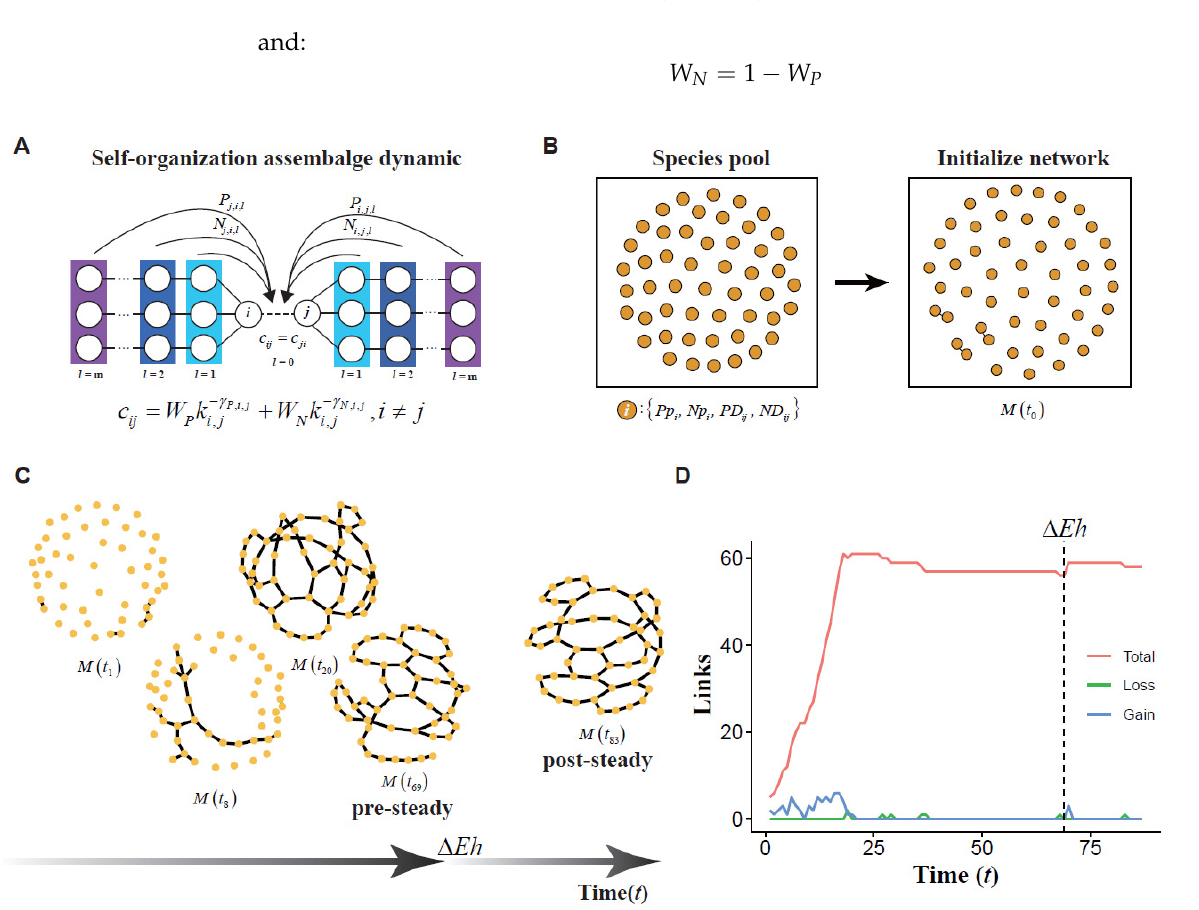
Figure 2. The simulation of self-organized assemblages in microbial networks. ( A ) The self-organized assemblages of microbial networks constrained by species phylogeny and niches. The connectivity c ij between species i and j is constrained by phylogeny ( P ) and niches ( N ). These two constraints could be directly affected by this pair of species ( l = 0) and their neighbor ( l = 1) or non-neighbor species ( l > 1). ( B ) Characteristics of species pool and network initialization. In species pool, species i has preferences in phylogeny ( Pp i ) or niche similarity ( Np i ). The phylogeny and niche distance between species i and j are denoted by PD ij and ND ij , respectively. For network initialization, three pairs of species are randomly selected and linked. The initialized network is denoted by symmetrical adjacent matrix M ( t = 0). ( C ) The simulation of self-organized assemblages in microbial networks. Symmetrical adjacent matrix M ( t ) was repeatedly updated according to network assembly procedures until termination events were triggered (See details in Supplementary Material) and the complete assembly of a pre-steady network. When environment heterogeneity changes ( ∆ Eh ), M ( t ) becomes involved in iterations until iteration termination and achieves a post-steady state. ( D ) The link dynamic in network assembly process. The red line is the number of network links across assembly time. The green and blue lines are the number of loss and gain links in assembly